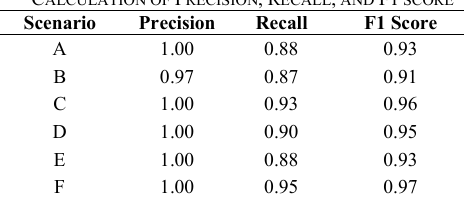
TABLE 5 C ALCULATION OF P RECISION , R ECALL , AND F1